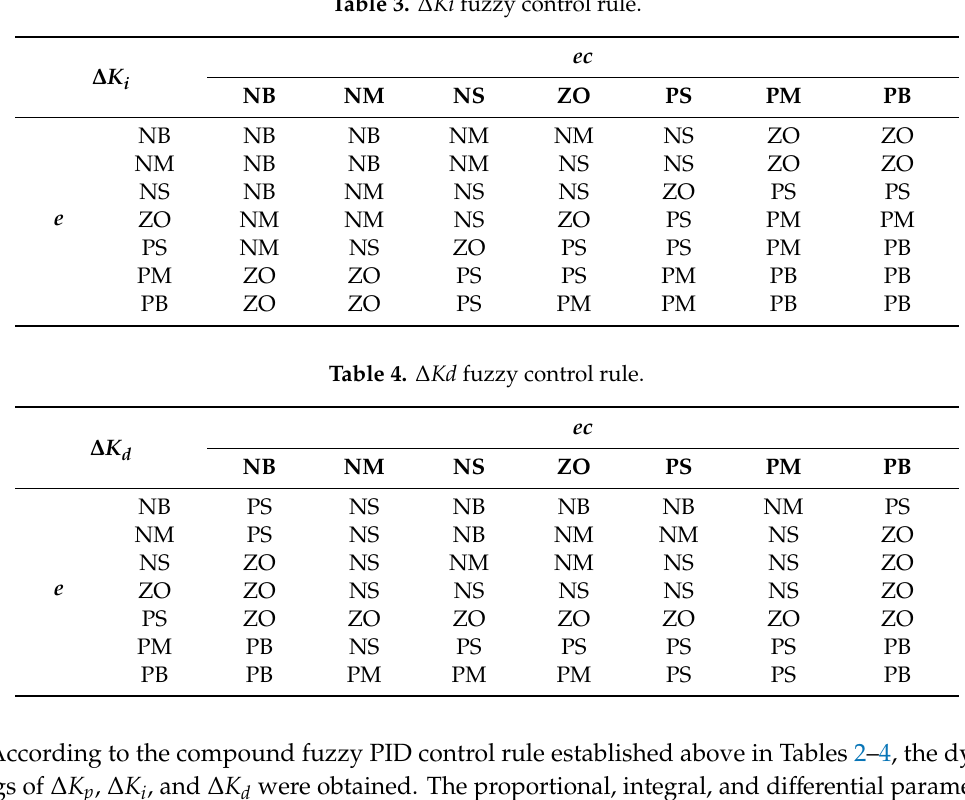
Table 3. ∆ Ki fuzzy control rule.